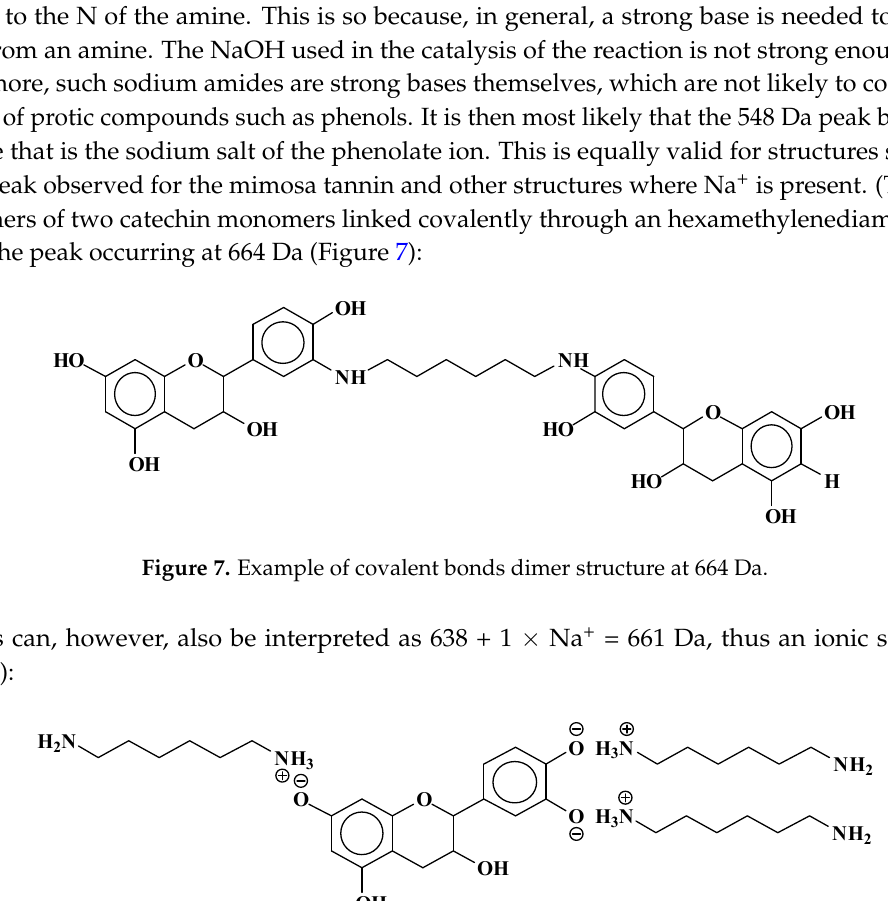
Figure 8. Example of ionic bonds salt structure at 661 Da.